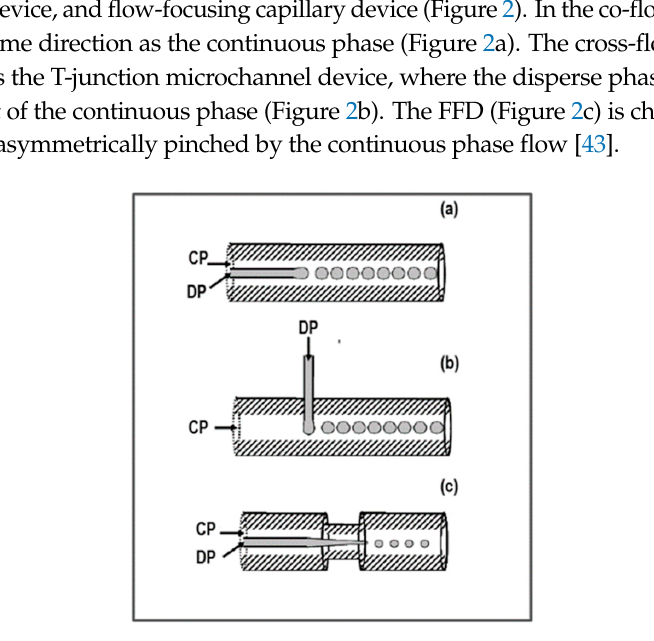
Figure 2. Capillary based devices: ( a ) Co-flow device; ( b ) cross-flow device; and ( c ) FFD device.